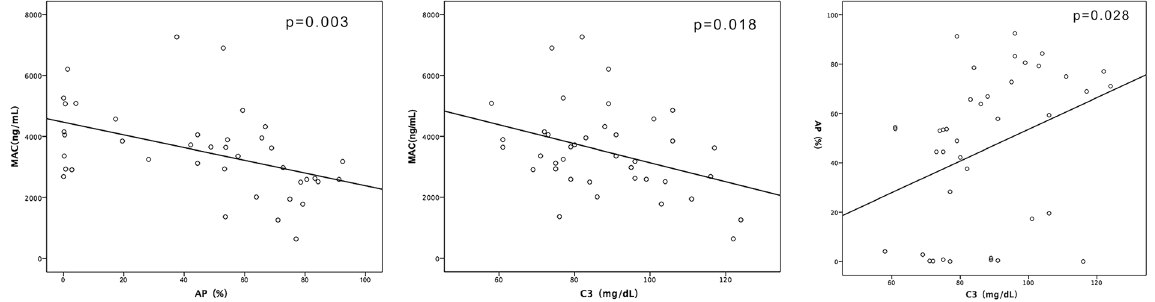
Figure 3. Correlation between serum C3 level, alternative pathway activation, and complement system activation in 40 FSGS